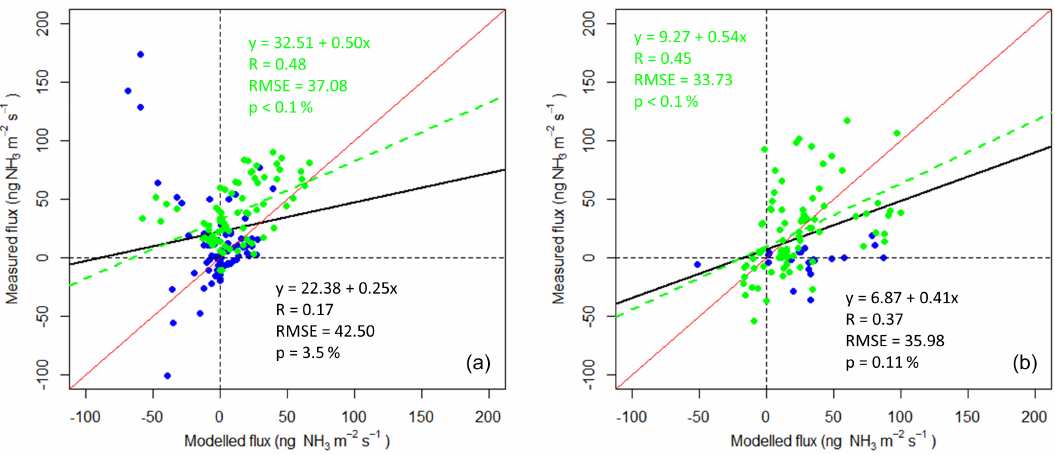
Figure 8. NH 3 fluxes simulated by GAG_field against the measured NH 3 fluxes in P2002 (a) and P2003 (b) . Green and blue dots represent the data for all time steps when measured fluxes were available. The green dots indicate only those time steps in which the measured flux was considered robust as shown in Fig. 9 (in (a) , the remaining data points on 27 August 2002 were also excluded as explained in Sect. 4.1.1). The figures show the fitted lines to the data points (thick black line for all of the data points, green dashed line for the green data points) in comparison with the 1 : 1 line (red line). The statistics indicated are the equation of the fitted lines ( y ), the Pearson correlation ( R ), the relative mean squared error (RMSE) and the level of significance of the relationship between the measured and modelled values ( p ) in the colour of the corresponding fitted